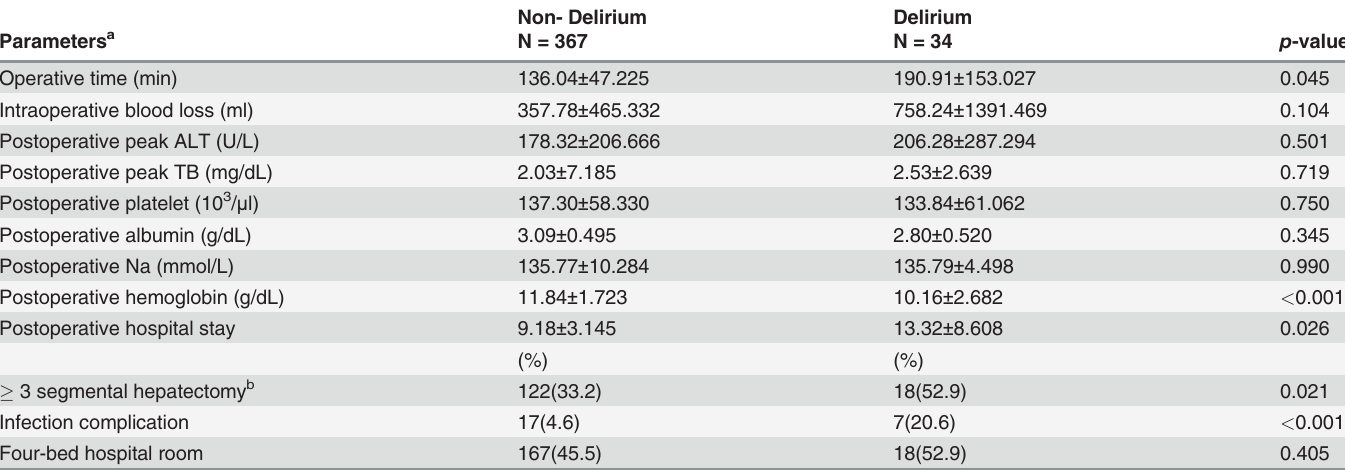
Table 3. Perioperative and postoperative features of patients in the delirium and non-delirium groups.